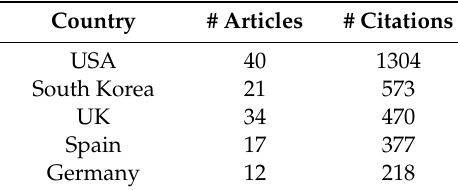
Table 4. Most productive and influential countries. Source: Own elaboration based on WoS.